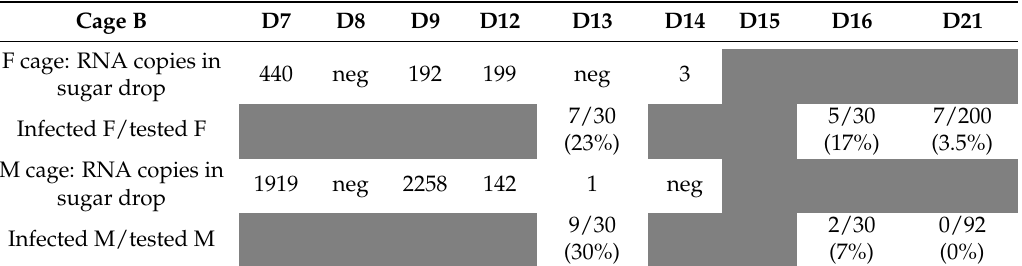
Table 2. Infection rate of females/males infected by “co-feeding on sugar”. Infection rate of females/males P. perniciosus infected by sugar meal transported from cage with infected females/males (A) by MASV into cage with non-infected females/males (B). neg, negative; F = female; M = male.